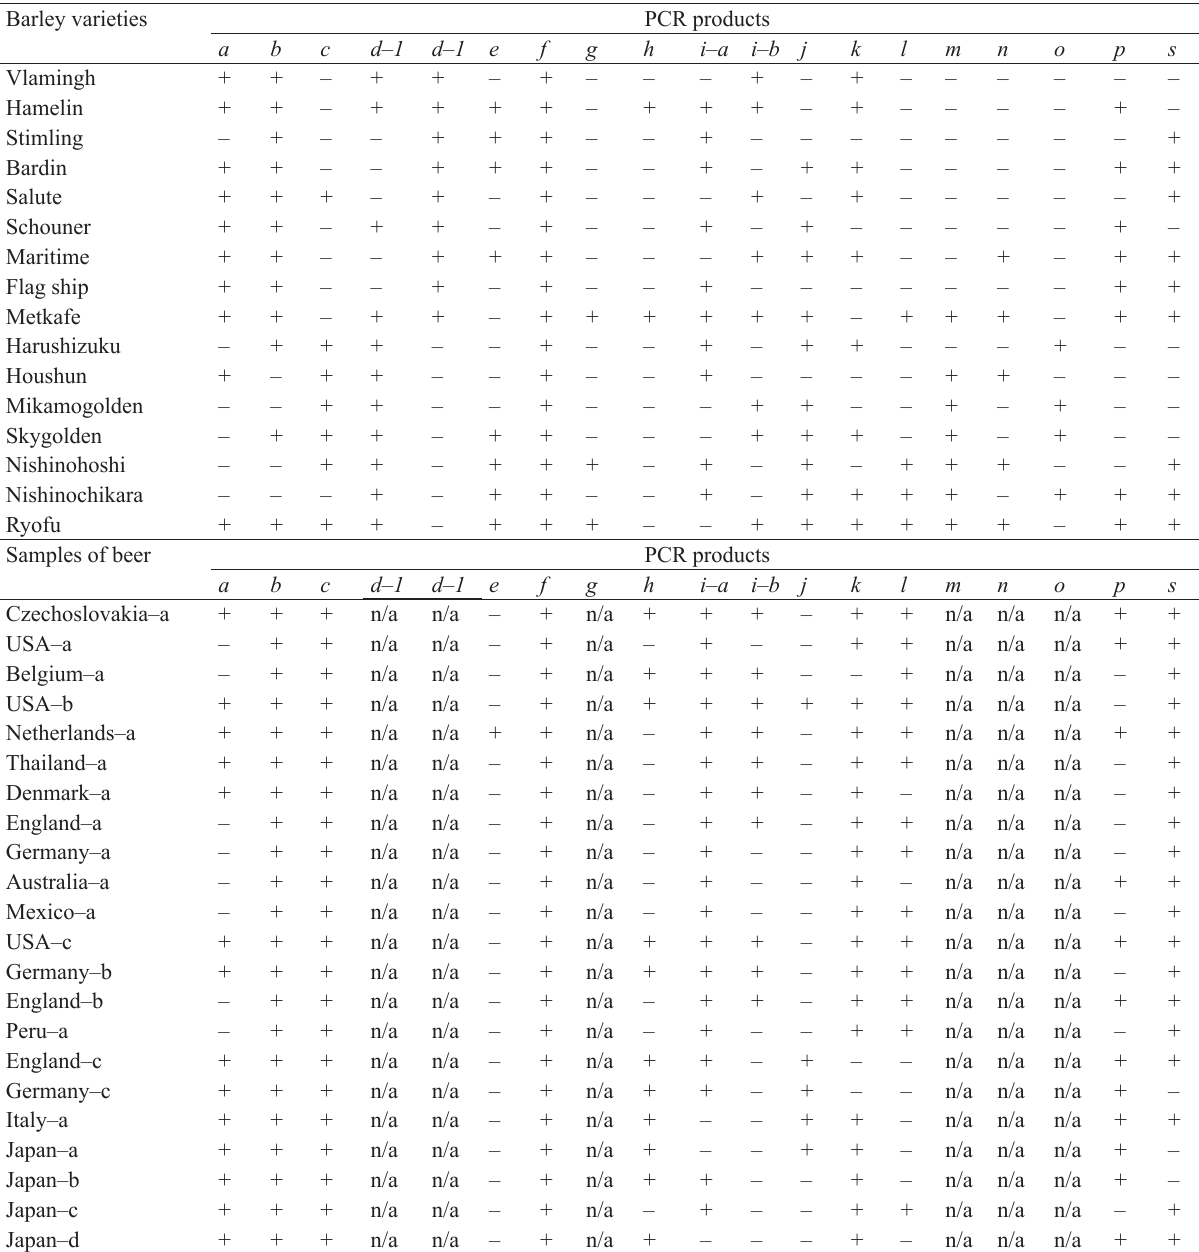
Table 2 Interpreted results of PCR analysis of brewing barley varieties and beer samples Barley varieties